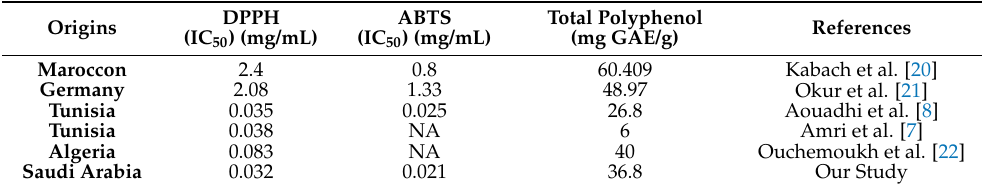
Table 2. Total polyphenol content and antioxidant activity of methanolic extract of M. vulgare re- ported in different studies.